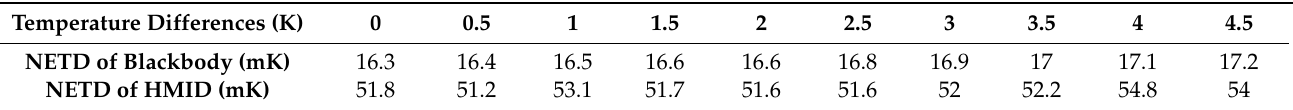
Figure 9. ( a ) Schematic diagram of the optical system used to measure the NETD parameters of HMID; ( b ) Actual optical system diagram for NETD parameter measurement of HMID; ( c ) Actual optical system diagram for measuring the detector’s NETD. Table 4. NETD measurements of blackbody and HMID.